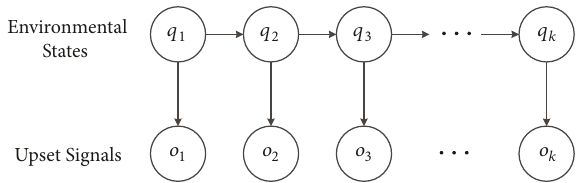
Figure 3: Hidden Markov model structure represented by Bayesian